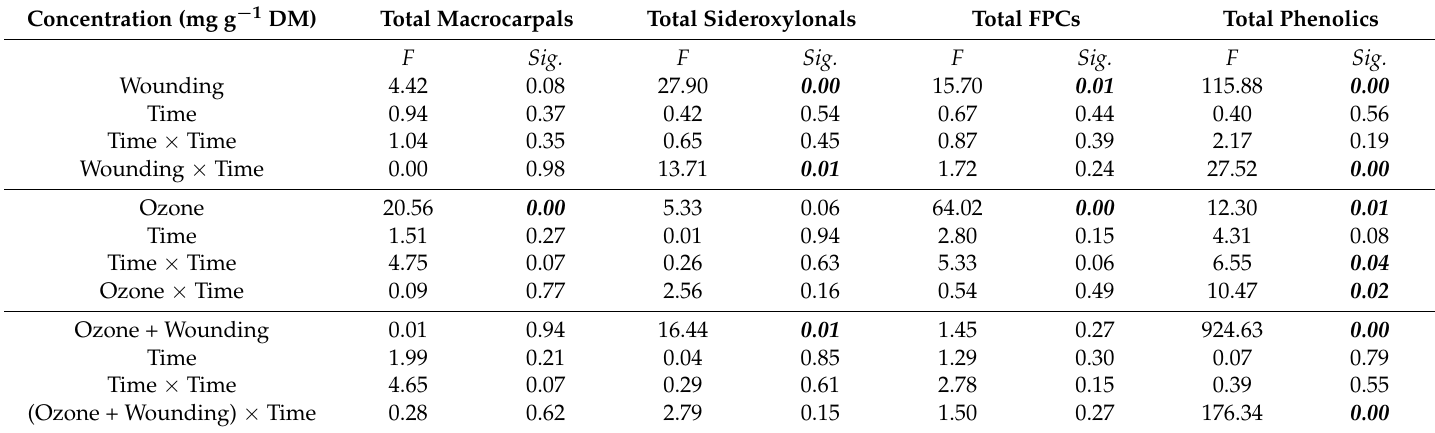
Table 3. Summary of the linear mixed model for the statistical effects of treatments (wounding, O 3 , and O 3 + wounding) and different recovery times on total macrocarpals, total sideroxylonals, total FPCs, and total phenolic contents in E. globulus leaves. Significant values are shown in italic and bold ( n = 3, Sig. <